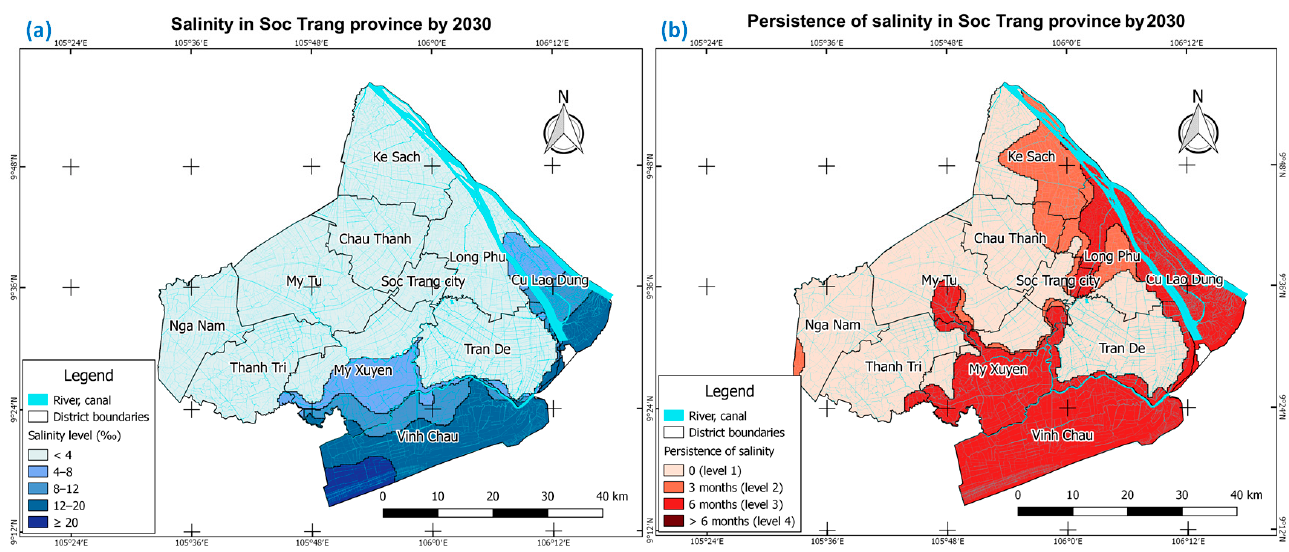
Figure 8. Saline instruction scenario. ( a ) Salinity map in 2030; ( b ) Persistence of salinity in 2030. (Source: Generated from DRAGON Institute, 2016 [41]).